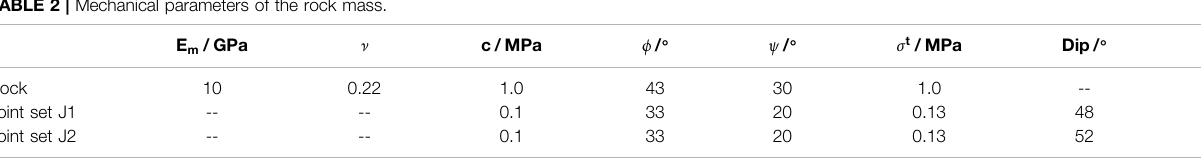
TABLE 2 | Mechanical parameters of the rock